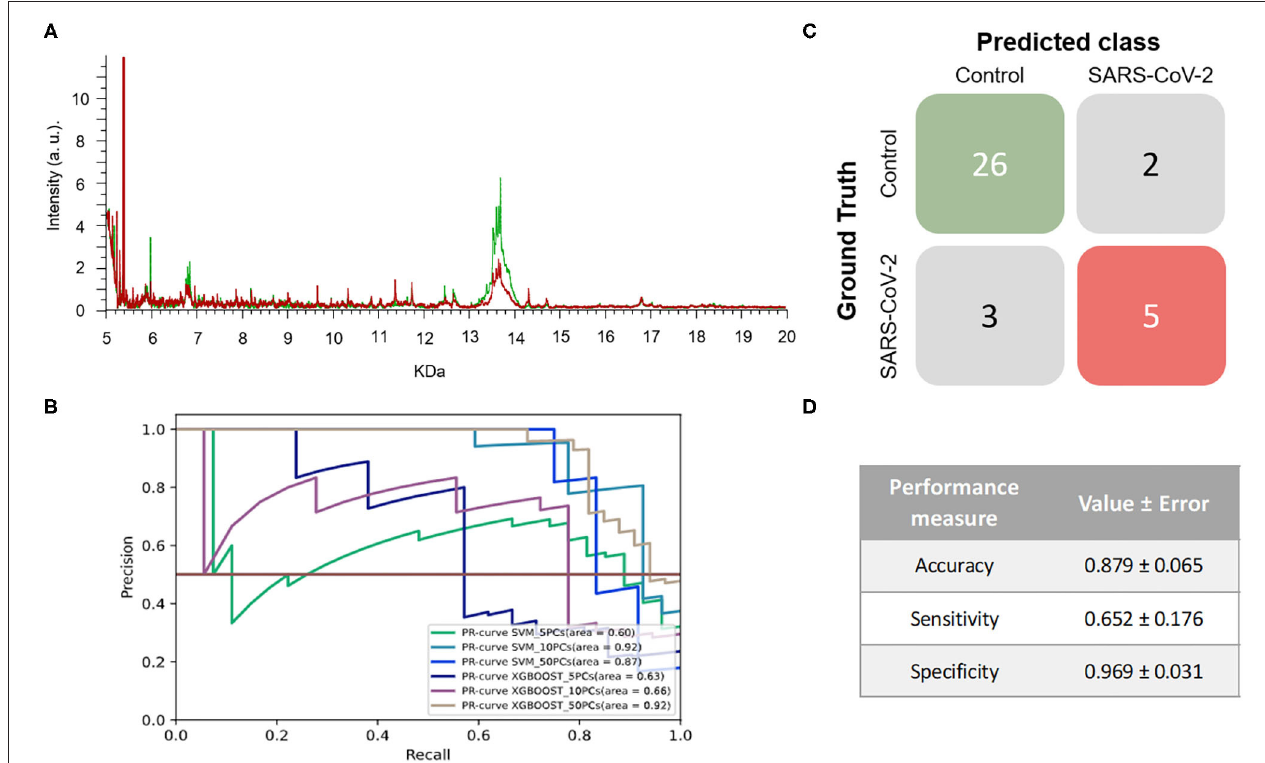
FIGURE 2 | Results for DeltaSwab-ViCUM (VTM1). (A) Representative mass spectra of NP samples for SARS-CoV-2: positive (red) and negative (green). (B) Precision-recall curve from the different models. (C) Average confusion matrix and (D) average performance metrics including their standard deviation (the test was performed 20 times selecting randomly different samples for each iteration) of the best model (SVM + 10PCs cross-validation K = 10).